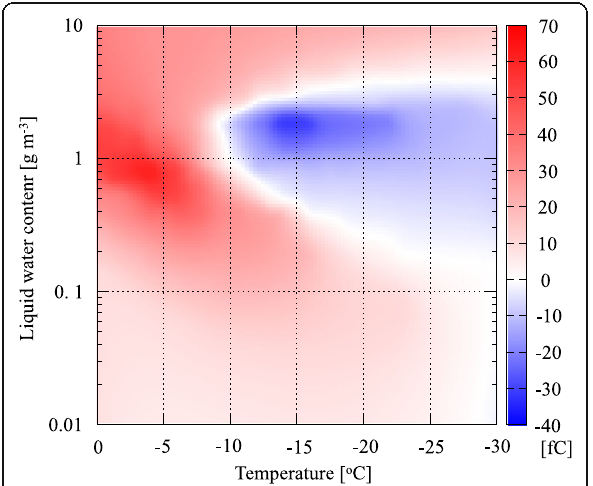
Fig. 1 Look-up table for the charge density of graupel with one collision, used for the charge separation process in SCALE. The data originated from Figure 8 of Takahashi